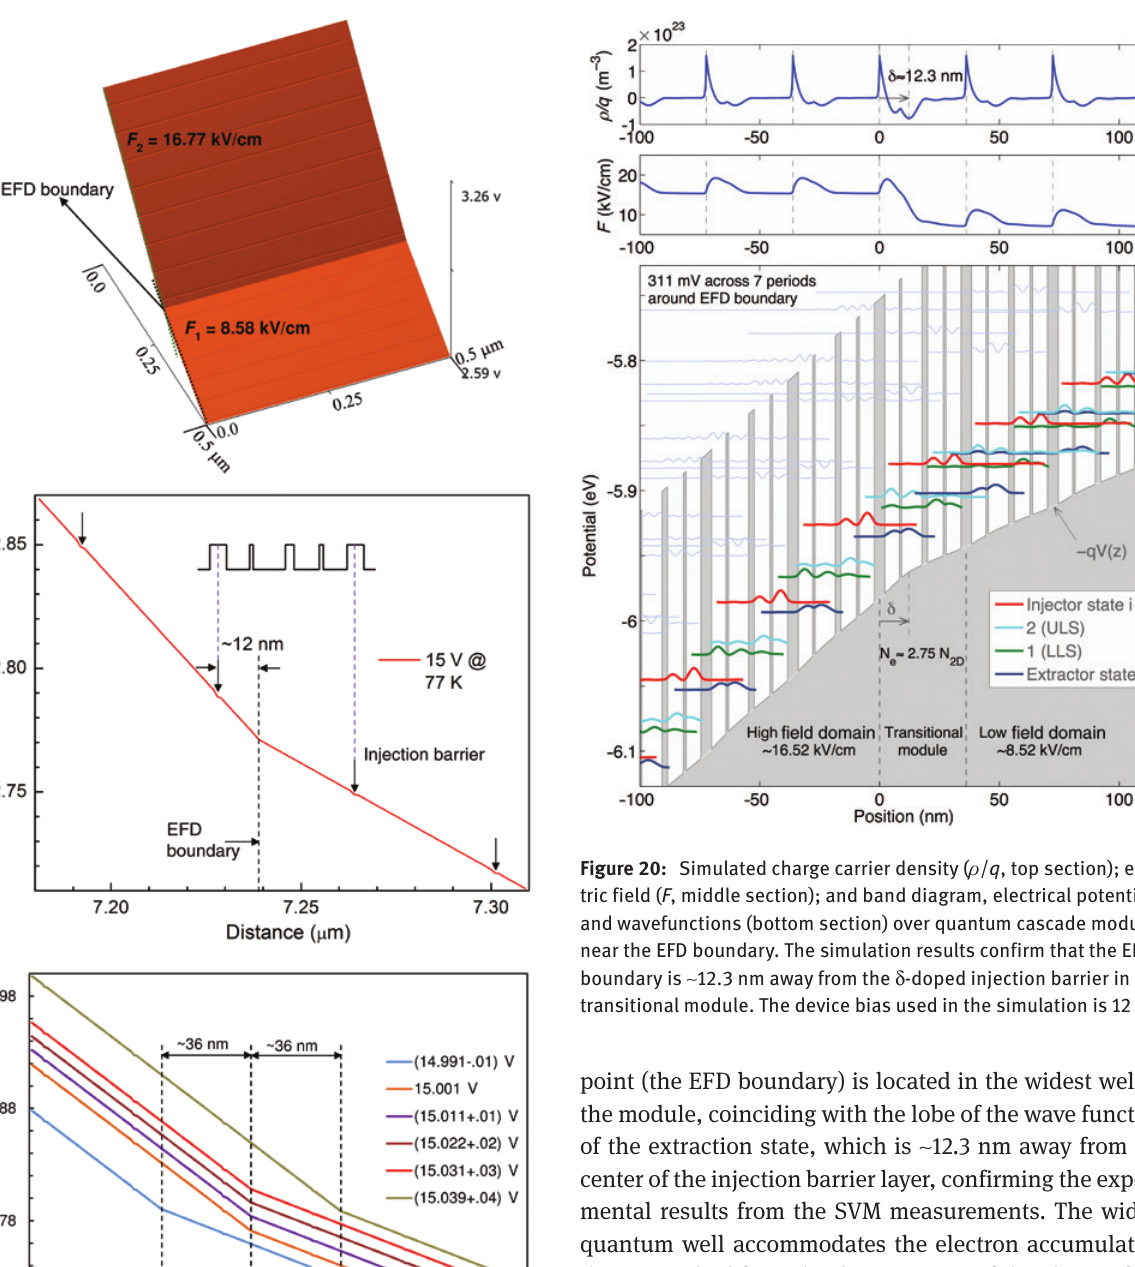
point (the EFD boundary) is located in the widest well of the module, coinciding with the lobe of the wave function of the extraction state, which is ~ 12.3 nm away from the center of the injection barrier layer, confirming the experi- mental results from the SVM measurements. The widest quantum well accommodates the electron accumulation that is resulted from the discontinuity of the electric field across the EFD boundary